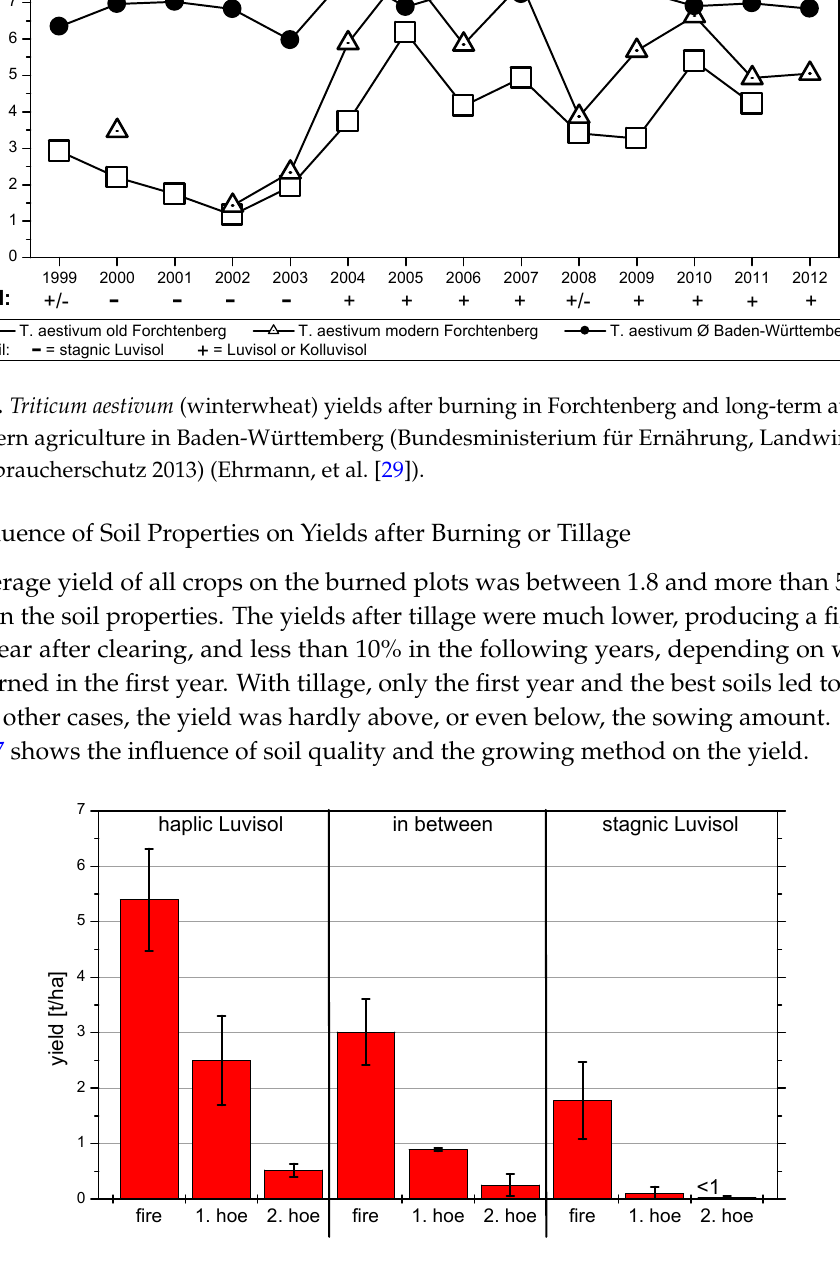
Figure 7. Crop yields. Mean values of Triticum aestivum (modern and old winter wheats) on